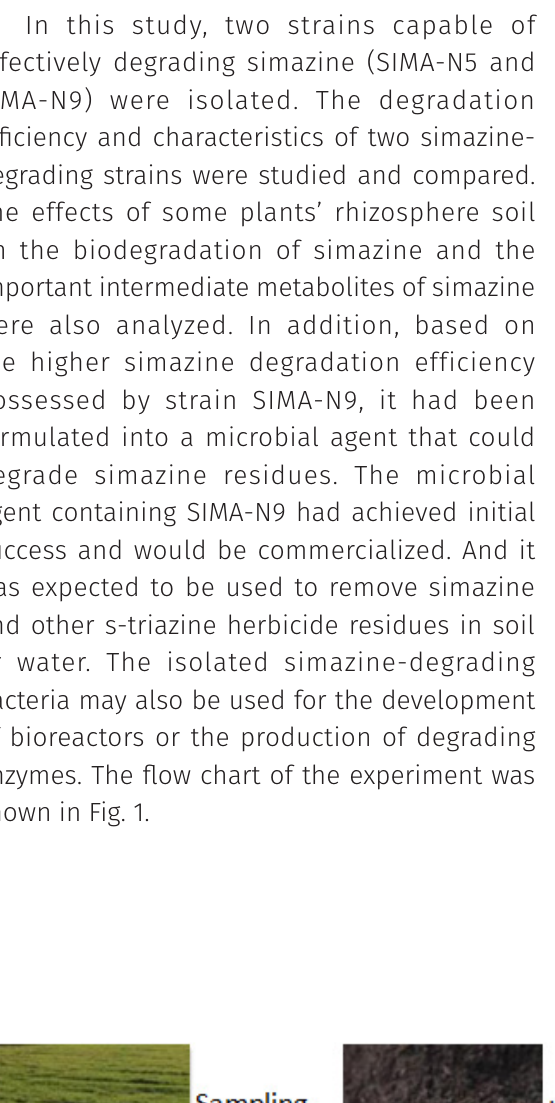
Figure 1. The flow chart of the